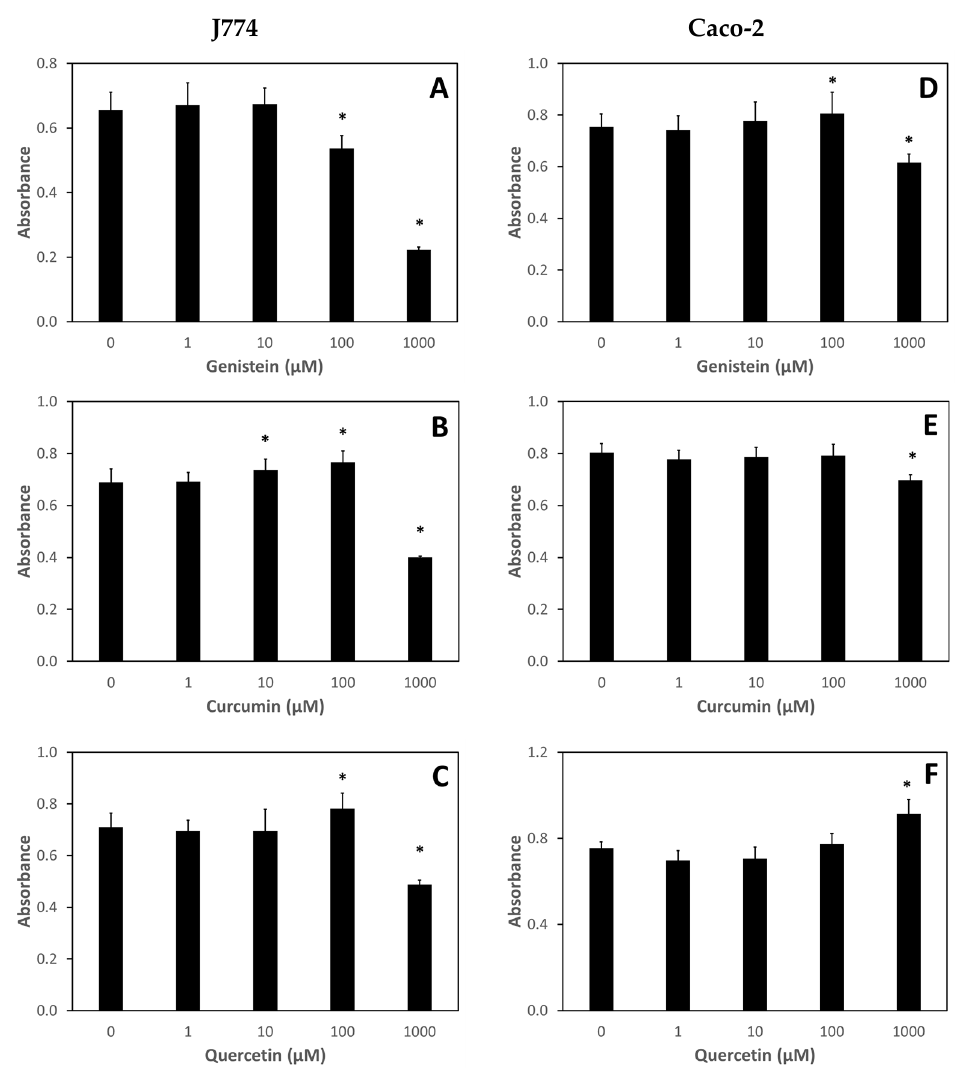
Figure 5. Effect of nutraceutical exposure on metabolic viability of J774 and Caco-2 cells. Cells were treated with various concentrations of nutraceuticals for 24 h after which metabolic viability was assessed using the MTT assay: ( A , D ) J774 and Caco-2 cells, respectively, with genistein; ( B , E ) J774 and Caco-2 cells, respectively, with curcumin; ( C , F ) J774 and Caco-2 cells, respectively, with quercetin. Data are the mean of three independent experiments. Error bars represent standard deviation. An * denotes a result statistically different from the no metal control as determined by unpaired t-test with significance at p < 0.05.